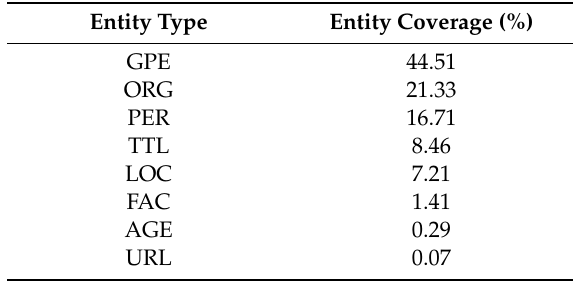
Table 9. Coverage of entity types in the initial annotated corpus.